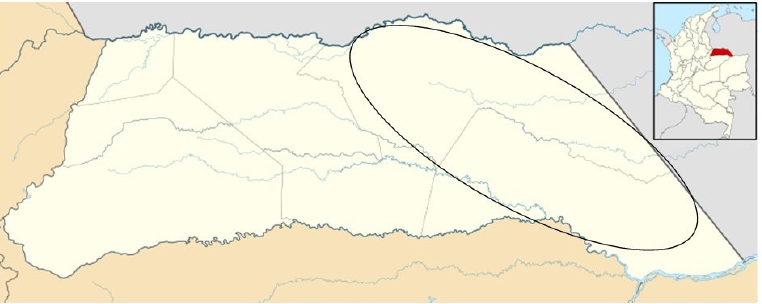
Figure 1. Floodplain savannah region, department of Arauca in Colombian eastern. Circle: flooded savannas ecosystem; Red color. Location of the department of Arauca in Colombia (latitude: 07°05 ′ 25 ″ N, longitude: 70°45 ′ 42 ″ W).